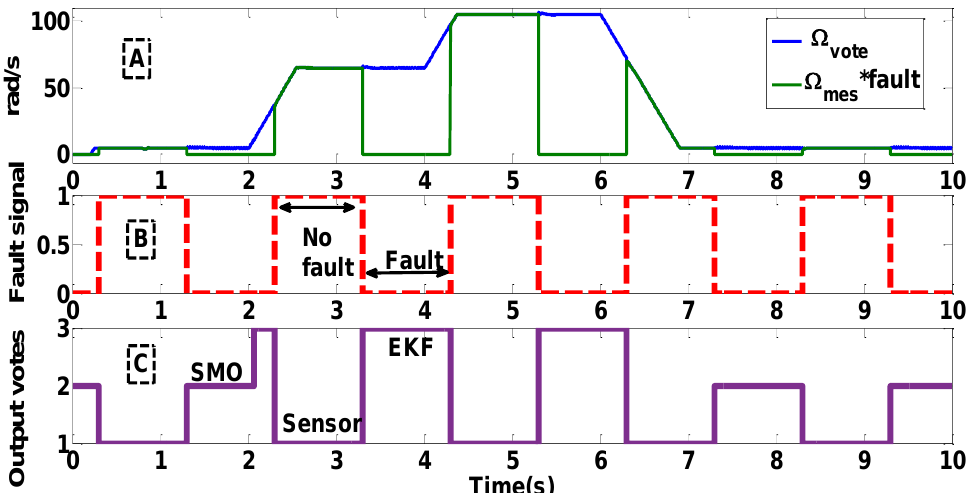
Figure 18. ( A ) The output of the proposed voting algorithm, ( B ) Applied fault signal, ( C ) Selected speed (1: sensor, 2: SMO, 3: EKF).